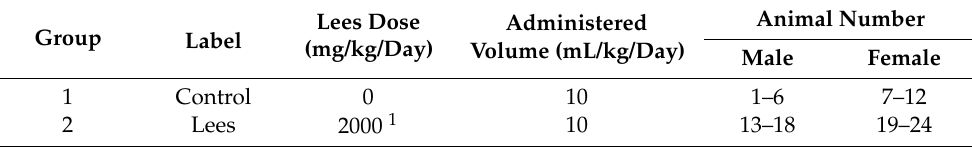
Table 1. Experimental design describing the two tested diets (control and lees diet).